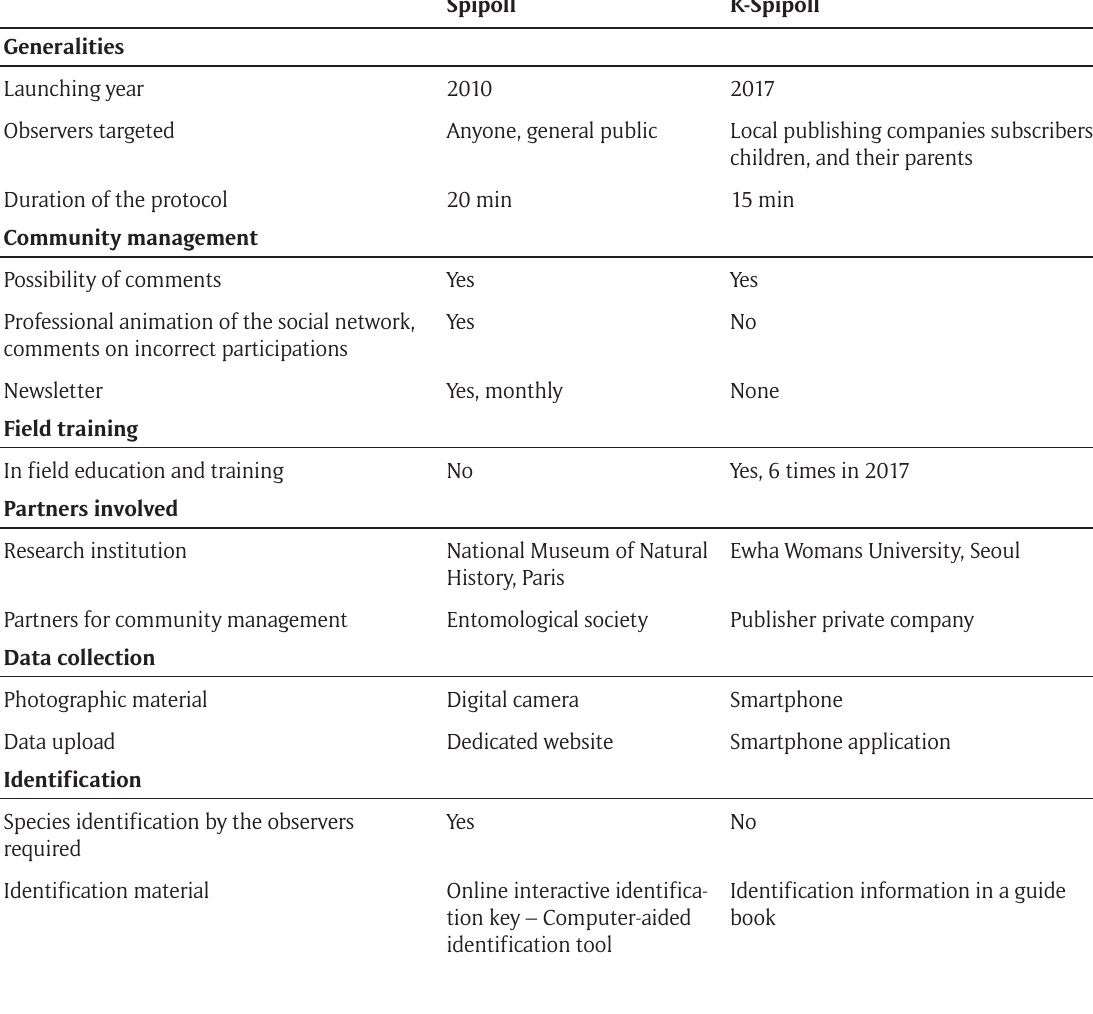
Table 1: Comparison of the methodologies for the K-Spipoll and the Spipoll.